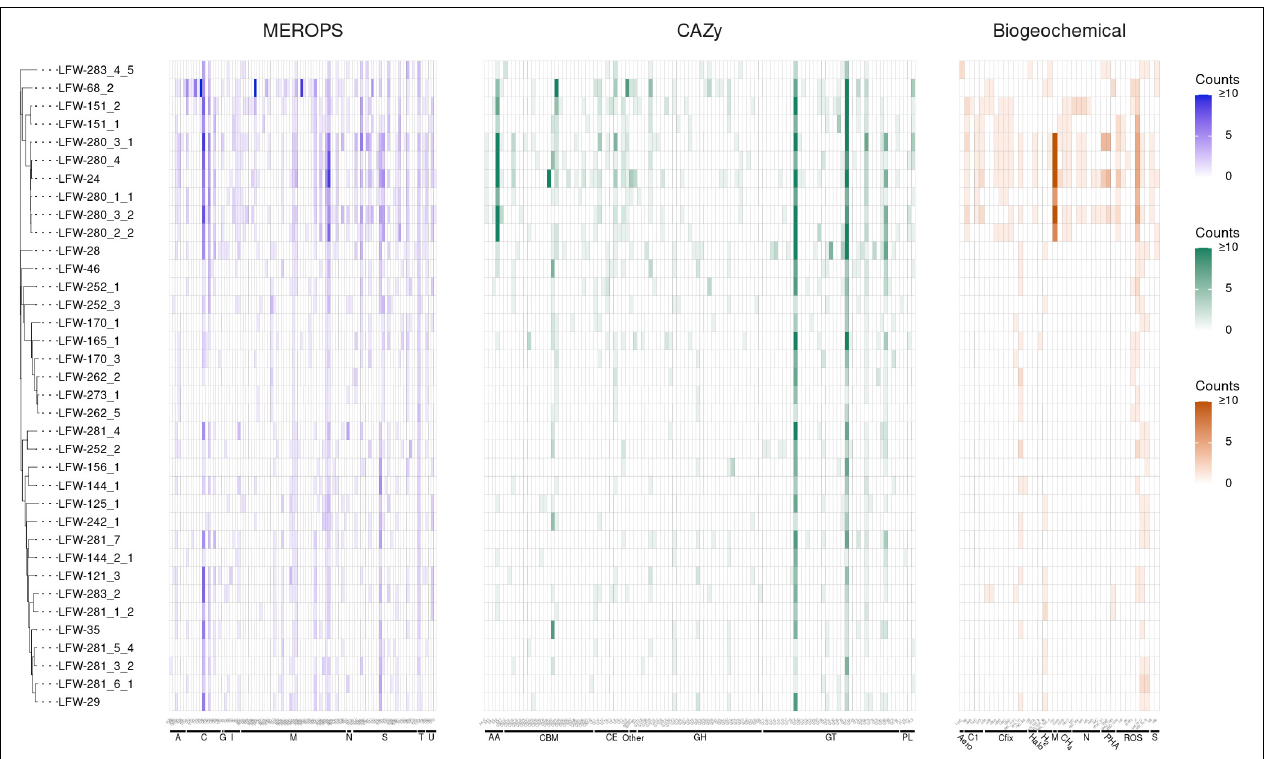
FIGURE 2 | Abundance of MEROPS subfamilies, CAZy families, and biogeochemically relevant proteins found in the MAGs from LFLS. MAGs are ordered according to the rp44 tree ( Figure 1 ). Counts of each protein are capped at 10 for easier visualization. Details about MEROPS, CAZy, and proteins of biogeochemical relevance, including exact counts and classes with predicted extracellular proteins can be found in Supplemenatry Tables 10, 11, 13 , respectively. Plot created with ggtree v3.1.0 (Yu, 2020) and ggtreeExtra v1.0.4 (Xu et al.,